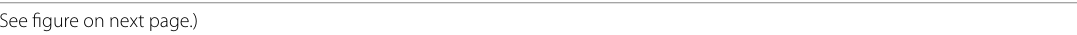
Fig. 4 Iba1-positive microglia infiltrate the intermediate cortex in the SAH mouse model (1.0 mm posterior to bregma). a Representative immunostaining images of Iba1-positive cells (red) in layers I to III of the intermediate cerebrum in the control, sham, mild SAH, and severe SAH groups. Scale bar, 100 μm for the general figure and 50 μm for the enlarged figure. b Representative immunostaining images of Iba1-positive cells (red) in layers IV to VI of the intermediate cerebrum in the control, sham, mild SAH, and severe SAH groups. Scale bar, 100 μm for the general figure and 50 μm for the enlarged figure. c Quantification of the number of Iba1-positive cells in layers I to III of the intermediate region of the cerebrum ( n 4, each group, control vs. severe SAH; p 0.001, sham vs. severe SAH; p 0.008). d Quantification of the number of Iba1-positive cells in = = = layers IV to VI of the intermediate region of the cerebrum ( n 4, each group, control vs. severe SAH; p 0.230, sham vs. severe SAH; p 0.025). e = = = Quantification of the number of Iba1-positive cells in all layers of the intermediate region of the cerebrum (n 4, each group, control vs. severe SAH; = p 0.005, sham vs. severe SAH; p 0.003). Statistical analyses were performed with one-way ANOVA and Tukey–Kramer post hoc tests. The values = = in the bar graphs represent the mean SE. * p < 0.05, ** p < 0.01, NS; ±